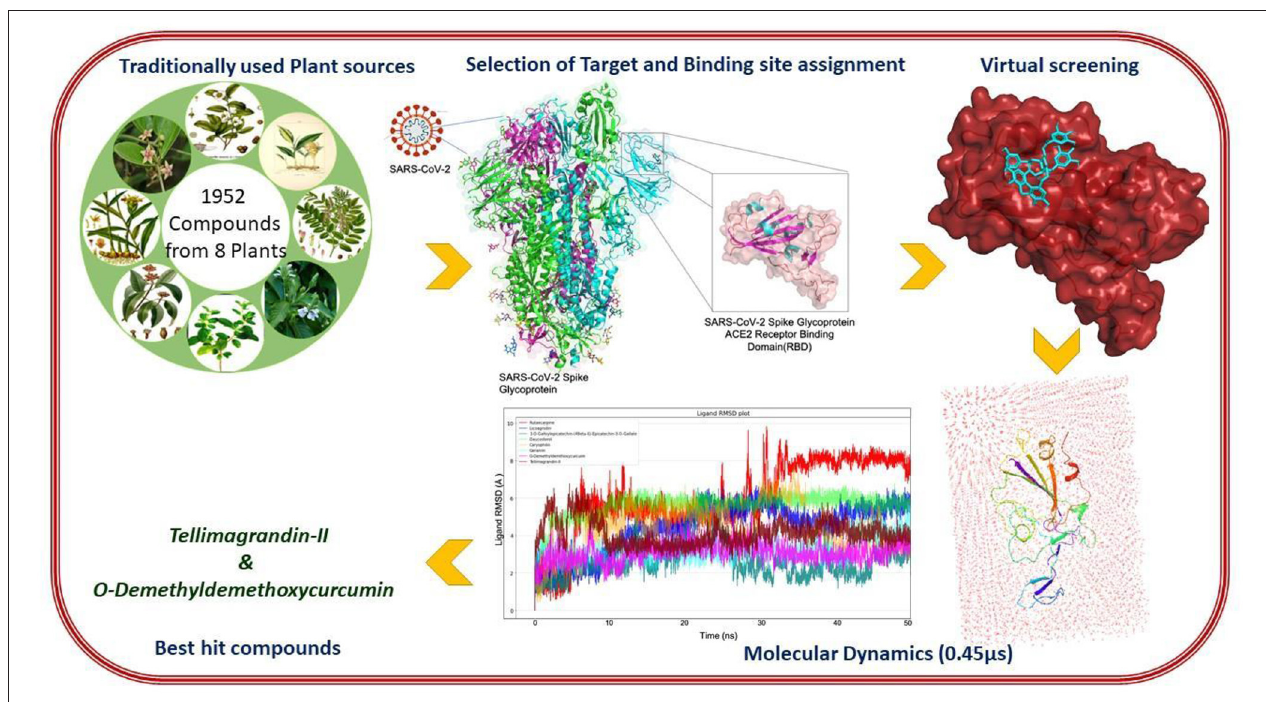
The S1 and S2 domains are present in individual monomers of the spike protein trimer ( Supplementary Figure 1 ).This 3D structure of protein complex has been recently elucidated using Cryo-Electron microscopy (PDB id: 6VSB) (rendered using PyMol) (6, 7). The surface unit 1 (S1) helps in the strong attachment of the spike protein to human cell receptors. The cleavage of S1/S2 helps in the entry of viral particles and the fusion of the viral capsid with the host cell membrane is guided by the S2 subunit (8). Several studies established that angiotensin- converting enzyme 2 (ACE2) receptor of the host cell is the mediator that facilitates viral entry (9, 10). Spike protein S1 domain is further divided into multiple regions that are involved in binding to host receptors. In Spike protein, 319–541 aa region (S1) is known as receptor binding domain (RBD) [PDB id: 7BZ5; Figure 3 ;